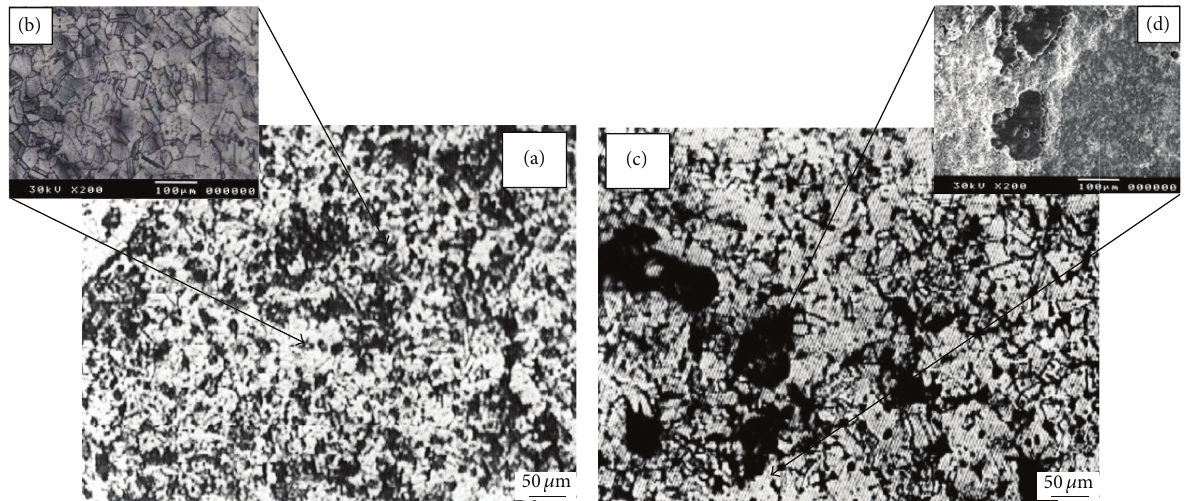
Figure 5: Optical SEM micrographs of heat-treated (a) 80% Cu-10% Sn-10% Pb, (b) with higher magnification, (c) 90% Cu-10% Pb alloys, and (d) with higher